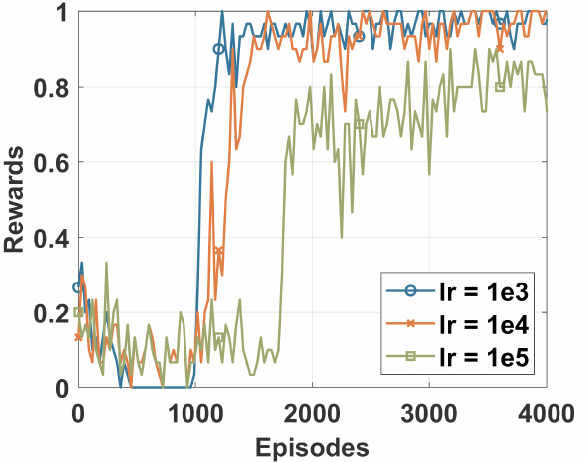
Figure 2. Training rewards of the DRL